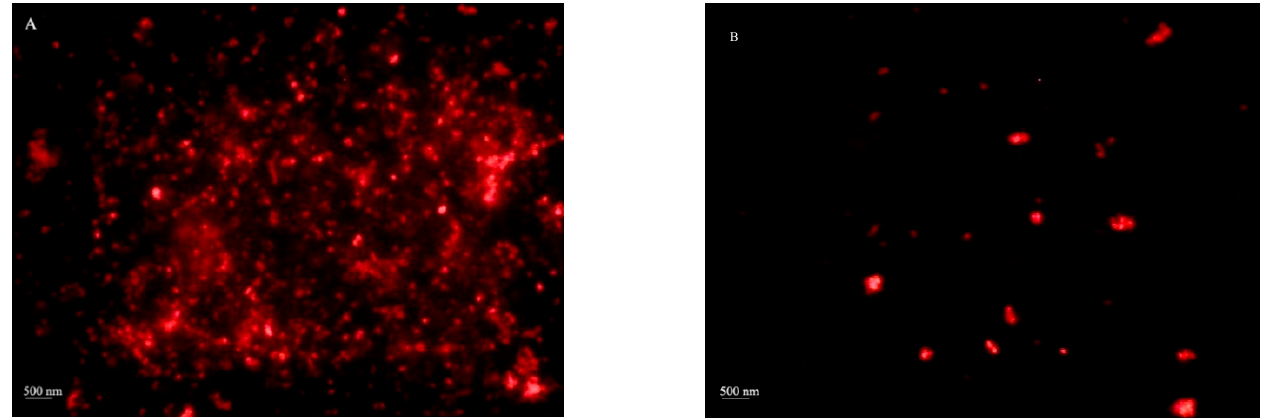
Figure 2. Micrographs of H 2 S-DOXO-loaded NP without HA (NP-H 2 S-DOXO 3% PVP) ( A ) and with 0.05% w/v HA (HA-NP-CTAB-H 2 S-DOXO) ( B ).